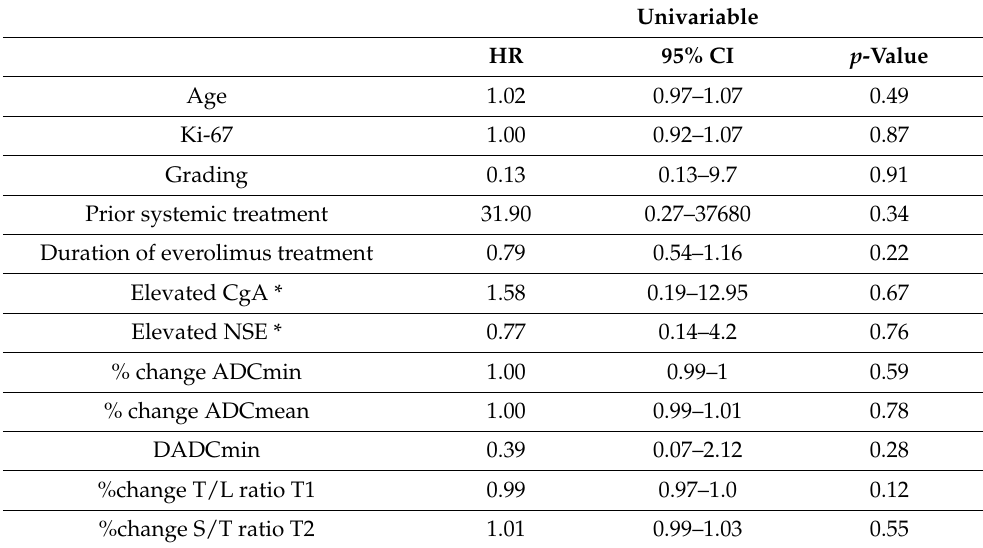
Table 3. Cox regression of